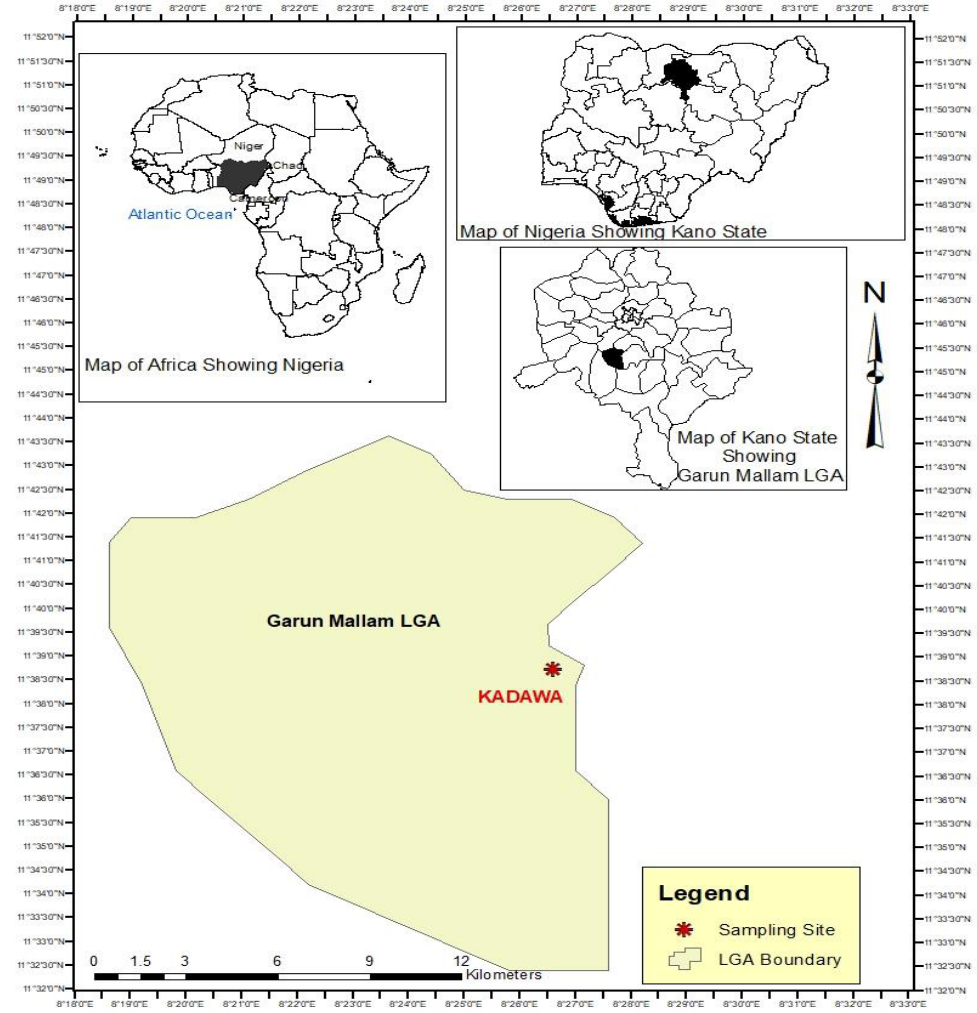
Figure 1. Sampling site, showing the location of Kadawa, Kano State, Nigeria.